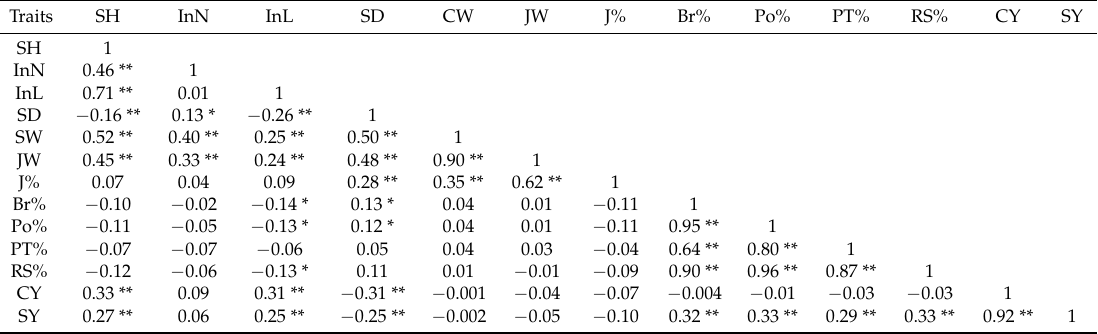
Table 3. Correlation coefficients among thirteen traits measured in 253 sugarcane accessions for mean measurement of two seasons.